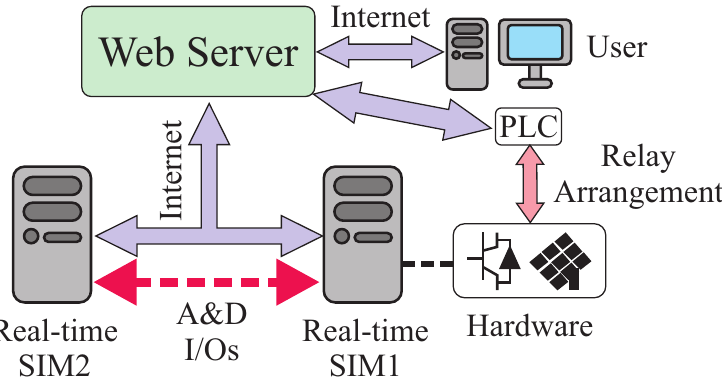
Figure 5. Architecture Virtual Laboratory Setup for PHIL